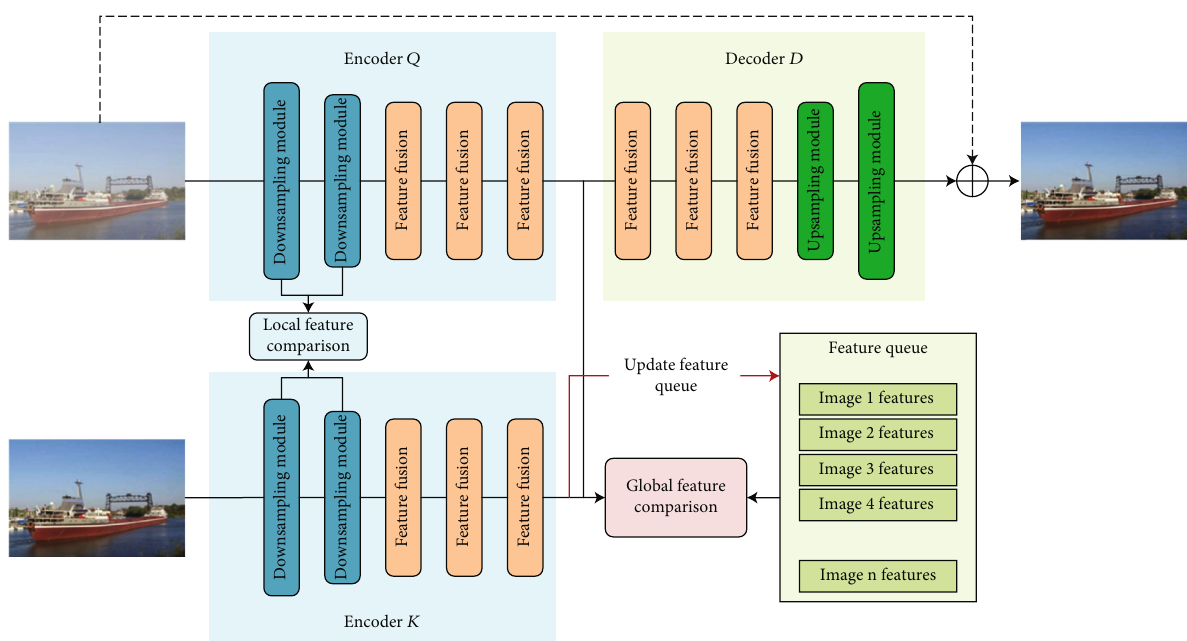
Figure 1: The fl owchart of our contrastive learning-based dehazing model, which consists of two encoders and one decoder, named Q , K , and D , respectively.